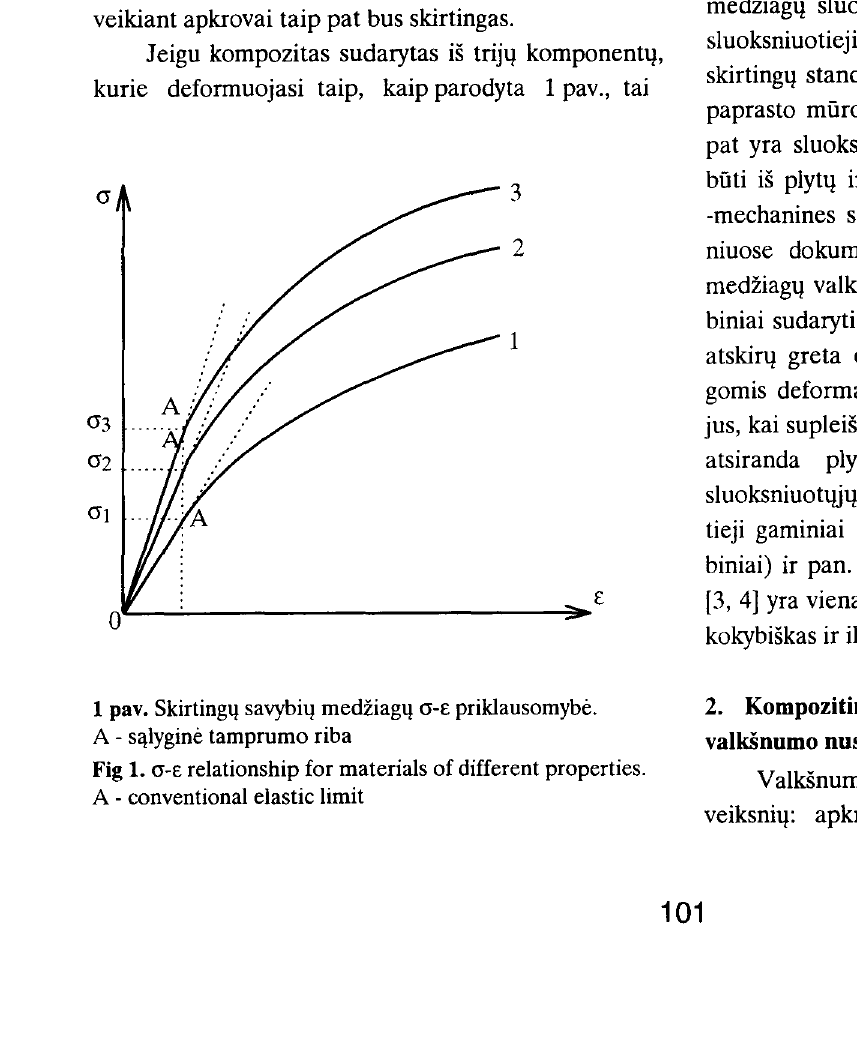
Fig 1. o-£ relationship for materials of different